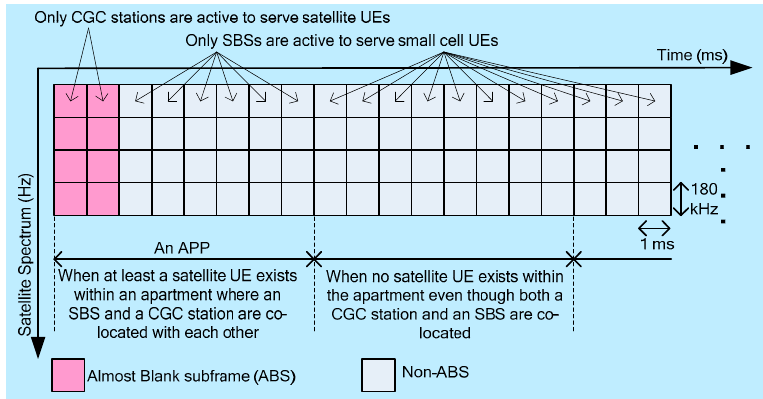
Figure 3. Interference management based on the ABS based eICIC technique for collocated SBSs with CGC stations in the same building [ 22 ].